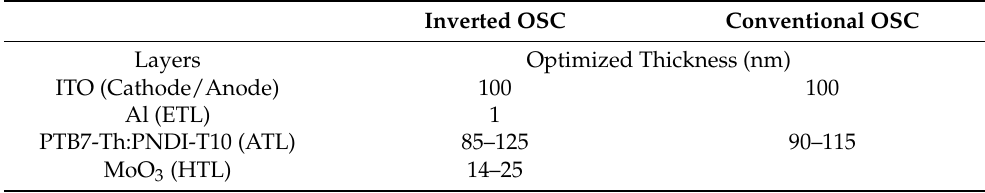
Table 2. Summary of the optimized components of the inverted and conventional OSC.